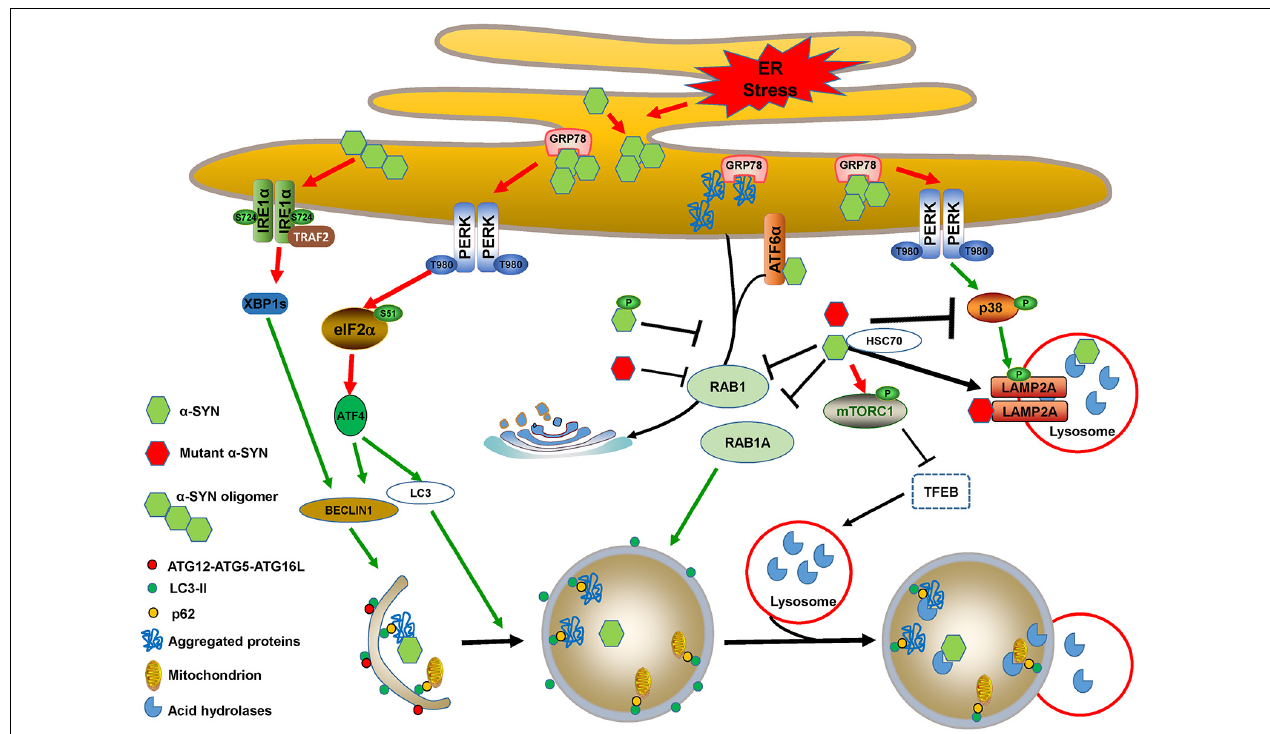
FIGURE 4 | Cross-links between ER stress and autophagy in α -SYN-mediated pathology. Accumulated α -SYN binds to GRP78 and activates ER stress. α -SYN also induces ER stress by binding to ATF6 and inhibiting its translocation to Golgi bodies. Additionally, wild-type, mutant, or phosphorylated α -SYN activates ER stress by inhibiting ER-Golgi trafficking, which leads to the accumulation of aggregated proteins. PERK/ATF4 activation that occurred due to ER stress induces BECLIN1 and LC3 expression. Oligomeric α -SYN directly activates the IRE1 α /XBP1s branch and thus induces BECLIN1 expression. The expression of BECLIN1 and LC3 triggers autophagy induction. However, wild-type and mutant α -SYN inhibit autophagosome maturation by repressing RAB1A function. They also activate mTORC1 and sequester TFEB in the cytoplasm to block autophagic flux by impairing lysosomal biogenesis and function. PERK activation-mediated MKK4/p38/LAMP2A phosphorylation may promote CMA for wild-type α -SYN degradation, whereas wild-type and mutant α -SYN directly inhibit p38 activation to block CMA, and mutant α -SYN can also inhibit CMA uptake by interacting with